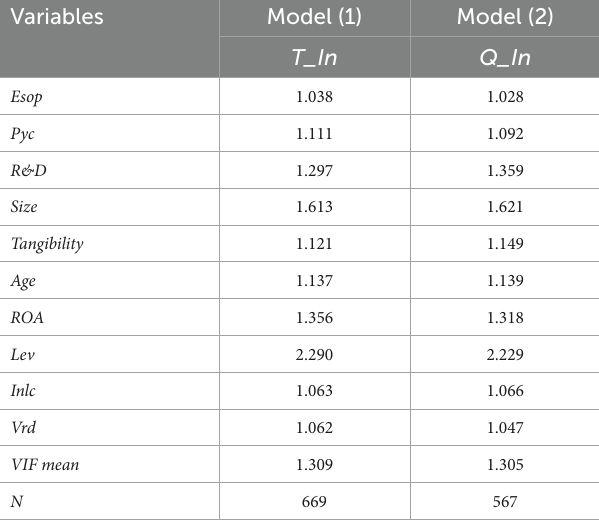
TABLE 4 Collinearity test result